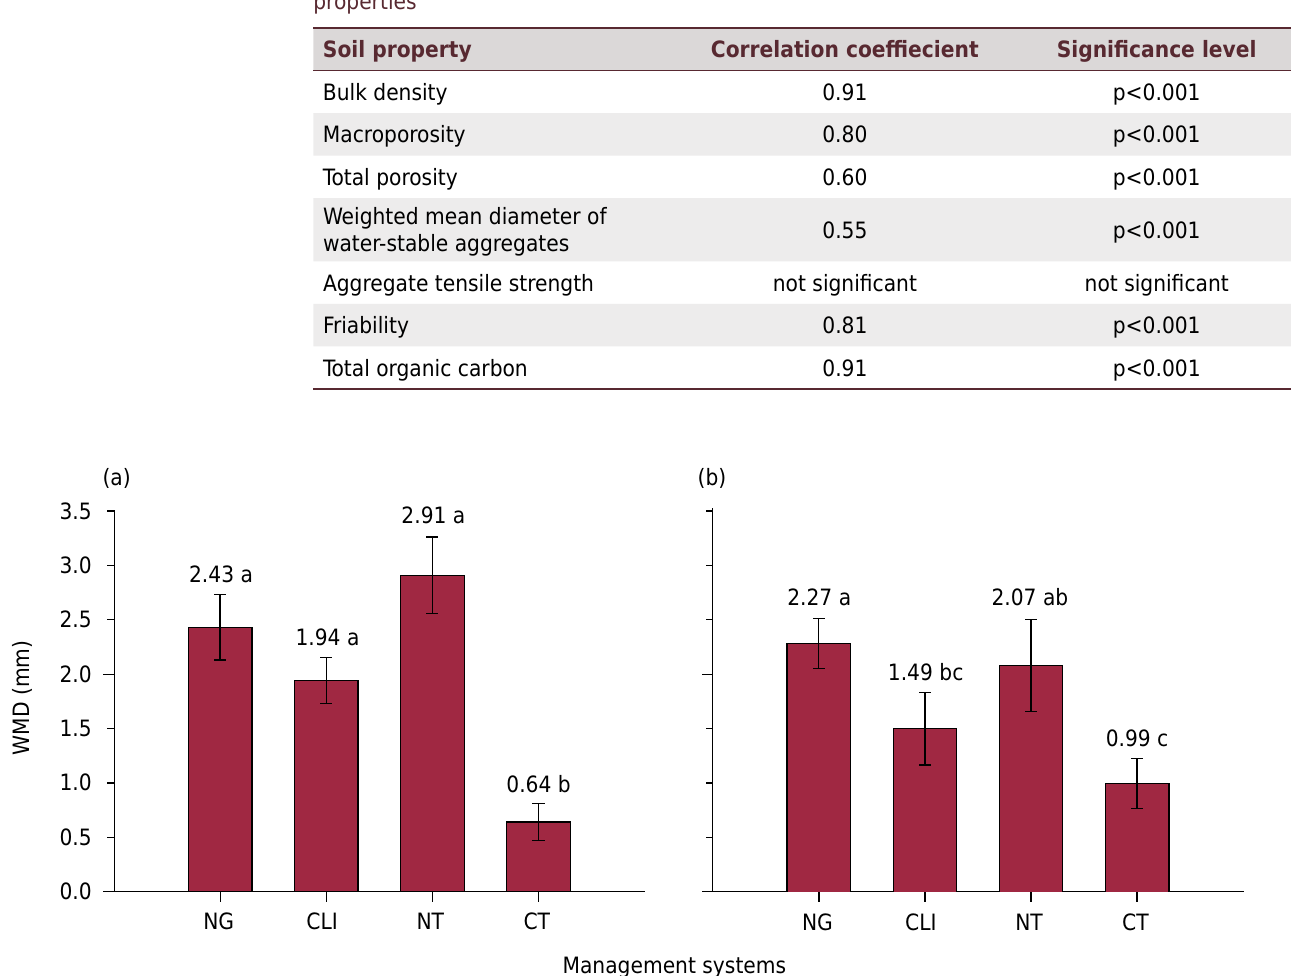
Figure 4. Weighted mean diameter of water-stable aggregates (WMD) (a, b) of an Albaqualf under different management systems in the 0.00-0.10 m layer (a) and 0.10-0.20 m layer (b). Vertical bars indicate the standard deviation. NG: native grassland; CLI: crop-livestock integration; NT: no-tillage; CT: conventional tillage system. Averages followed by the same lowercase letter in a column, within each variable and soil layer, did not differ significantly by Duncan’s test at 5 %. Vertical bars indicate the standard